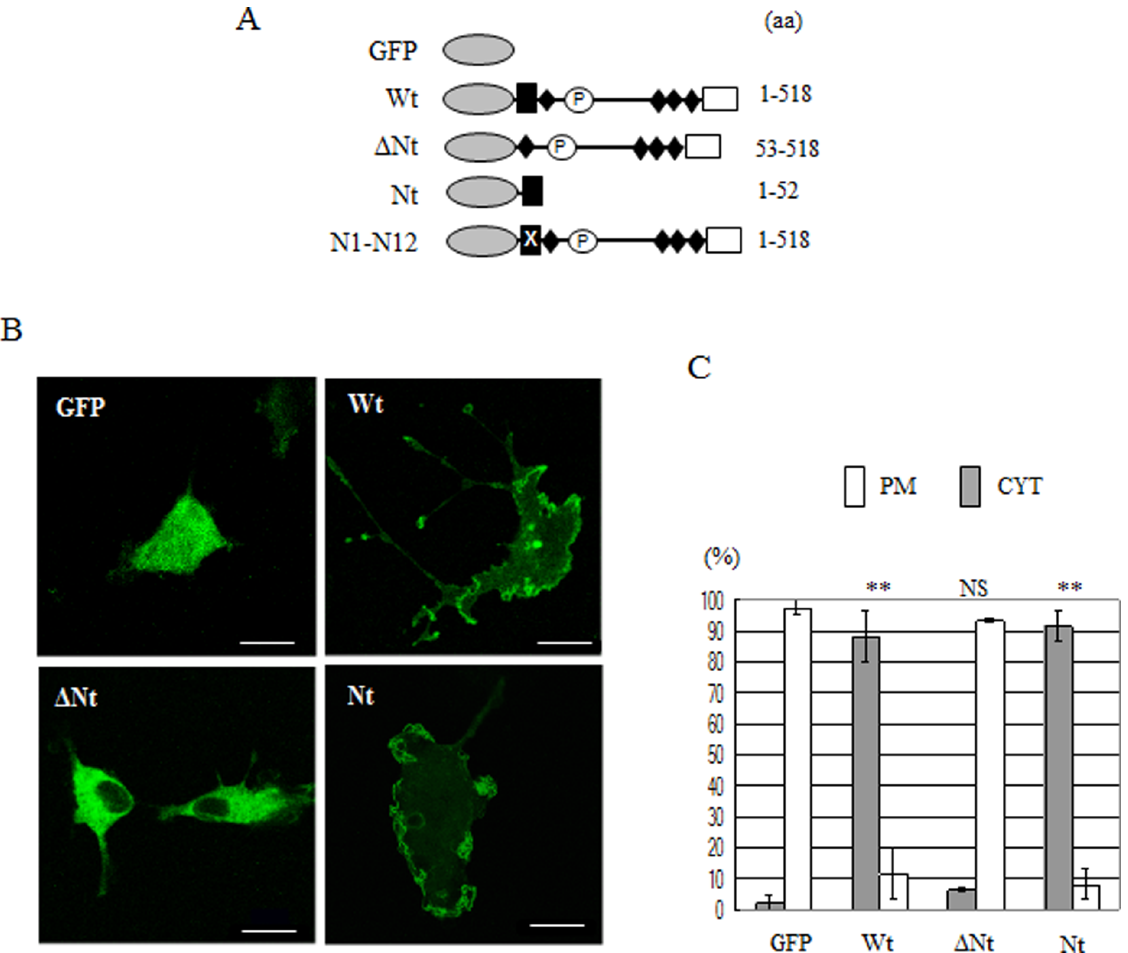
Figure 2. The N-terminal region (Nt) is responsible for the distribution of phactr3 in the plasma membrane. (A) Deletion mutants of GFP-phactr3 used in this study. (B) GFP and GFP-phactr3 constructs were expressed in Cos7 cells and their subcellular distributions were observed by confocal laser scanning microscopy. Bars, 20 m m. (C) The numbers of cells with predominantly plasma membrane (PM) distributions and cytoplasm (CYT) distributions were counted by fluorescence microscopy. The mean and standard error (SE) were calculated on the basis of three independent experiments (shown in the figure as mean 6 SE). The asterisks in the histograms indicate significant differences between Wt and each mutant (Student’s t-test; ** P , 0.005). NS, not